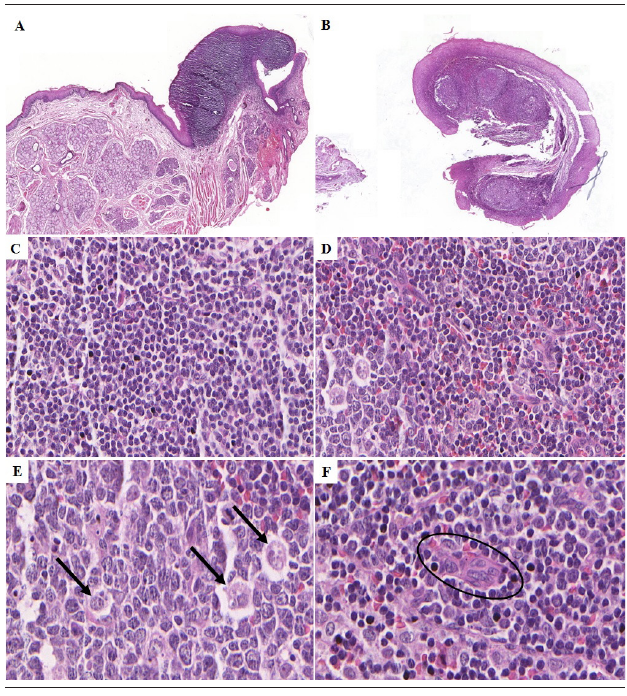
FIGURE 2 – Histopathological characteristics of oral lymphoid hyperplasia A) presence of primary lymph nodes in close proximity to the oral mucosa lining epithelium; B) secondary lymph nodes with the formation of well-defined germinal centers (HE, pannoramic viewer – 1000 µm); C) interfollicular areas populated by small lymphocytes; D) lymphocyte with typical mitosis figure (black circle) in interfollicular region; E) presence of macrophages (black arrows) in the germinal centers of secondary lymphatic follicles; F) presence of epimioepithelial island (black circle) (HE, pannoramic viewer – 50 µm). HE: hematoxylin and eosin.